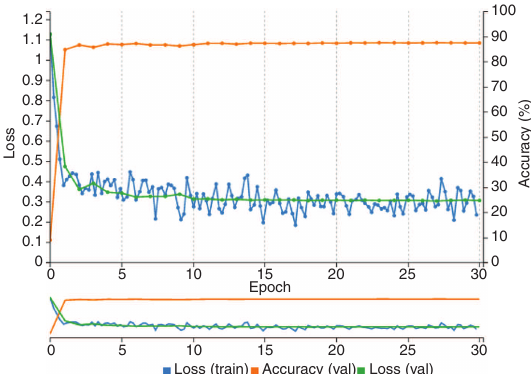
Figure 36: Training Process of Experiment 3.